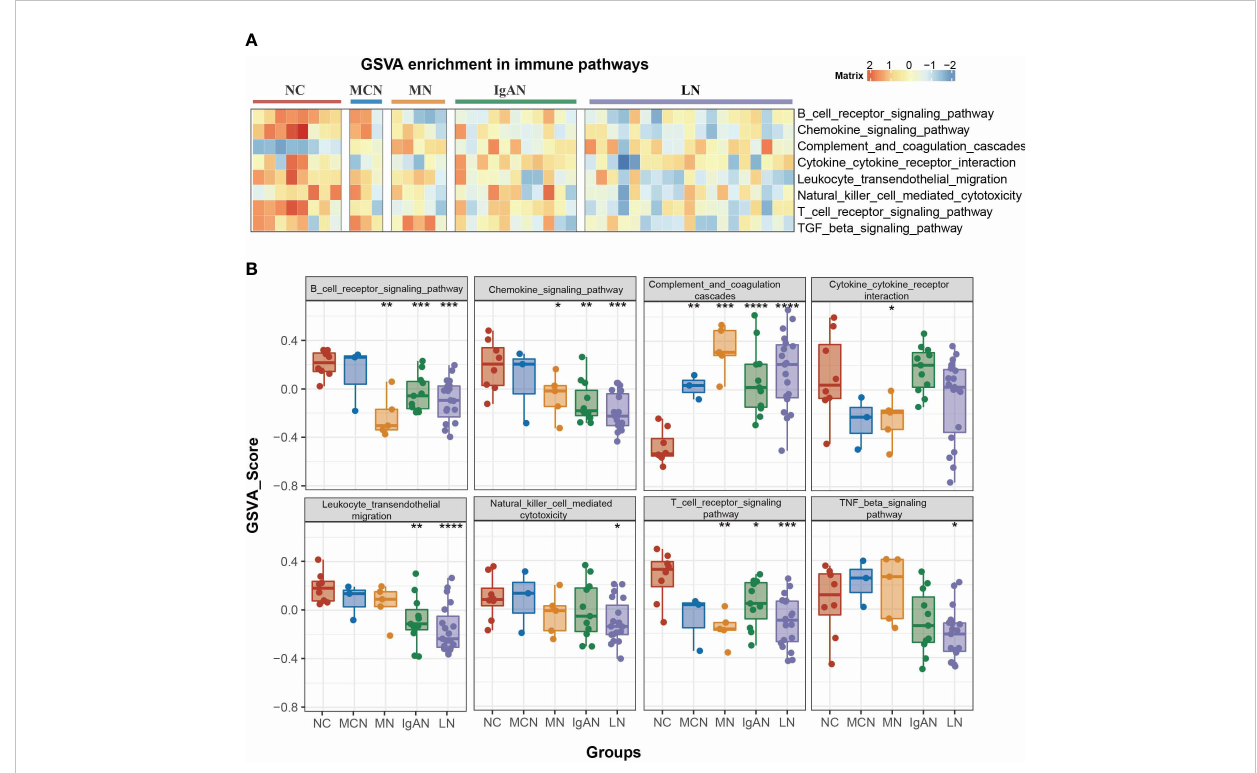
FIGURE 2 Pathway analysis of four GNs diseases. (A) The heatmap of enriched immunity pathways of each clinical sample in the four GNs diseases by GSVA analysis. (B) Bar plot representing GSVA score of each clinical sample in the four GNs diseases. Versus NC group; * P < 0.05 , ** P < 0.01, *** P < 0.001, **** P <